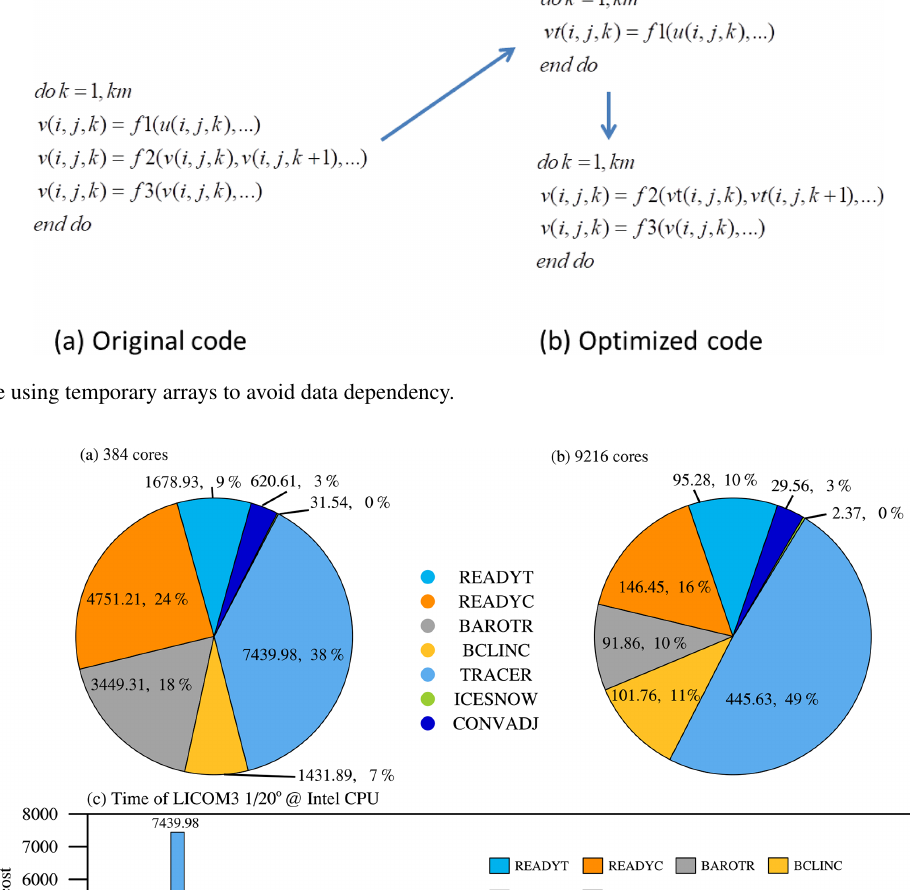
tine. The communication of barotr is 45 times more